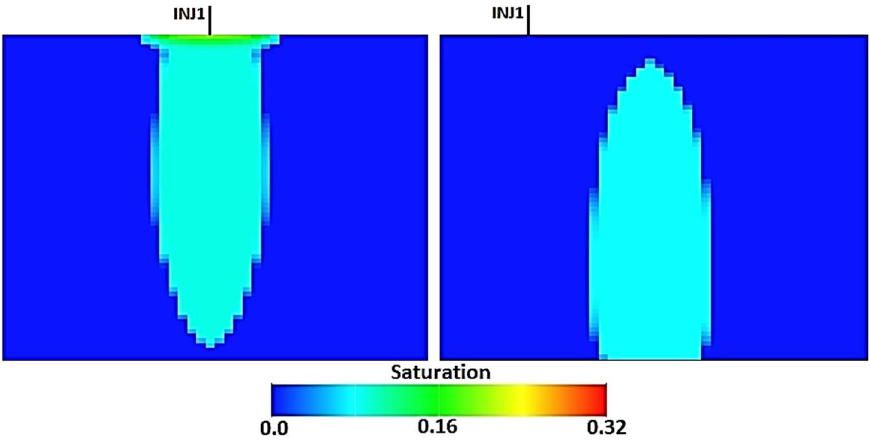
Figure 11. Gas saturation distribution by vertical ( left ) and horizontal well ( right ).